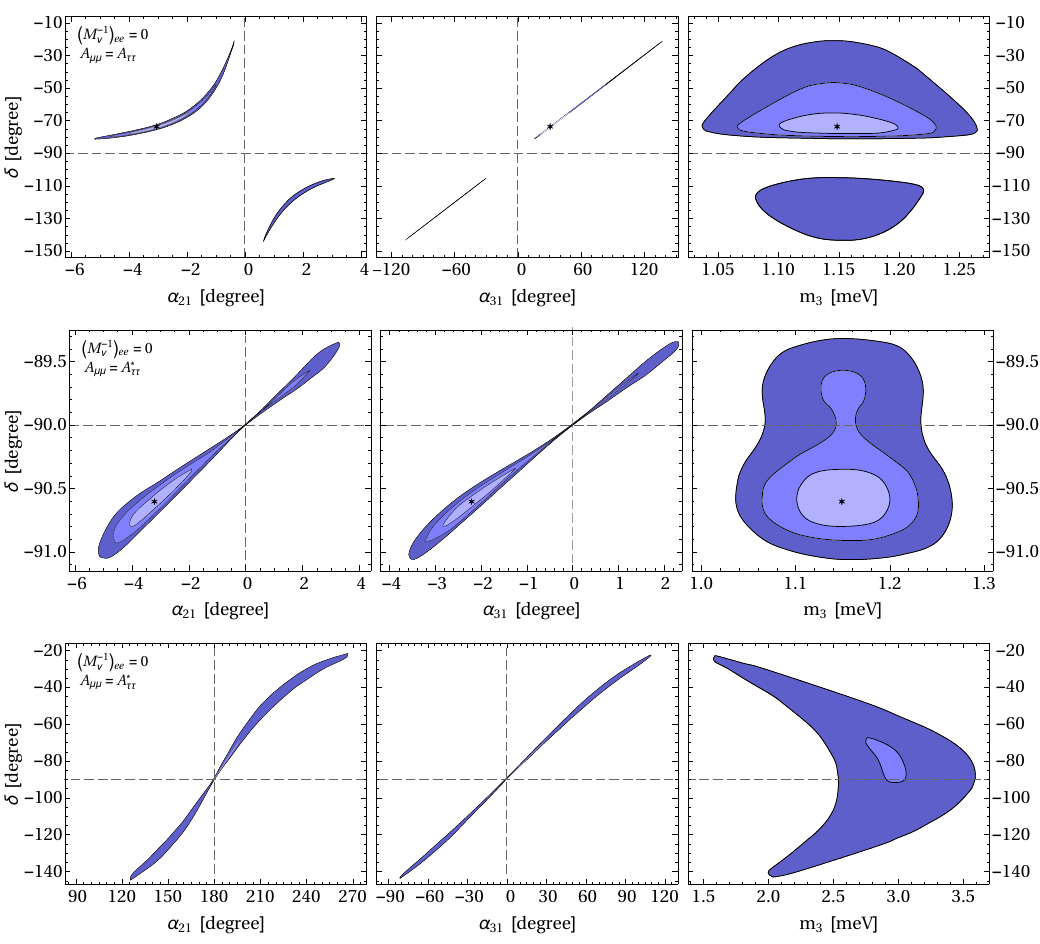
Figure 7 . The same regions as in the right panels of (cid:12)gure 6 are now depicted in the (cid:14) { (cid:11) 21 plane (left panels), (cid:14) { (cid:11) 31 plane (central panels), and (cid:14) { m 3 plane (right panels). The top row is for model 6; the central and bottom rows are for each of the two solutions of model